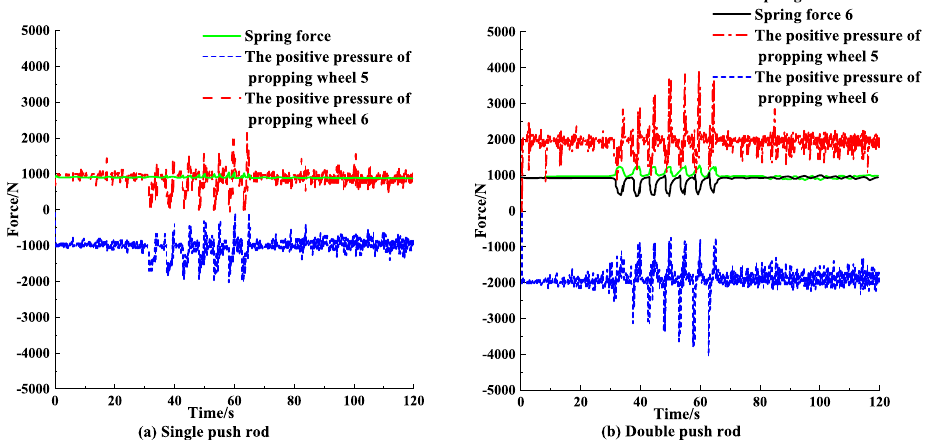
Figure 17. The positive pressure change of propping wheel of single push rod support adjustment mechanism, double push rod − double spring support adjustment mechanism when crossing the casing reduction and casing